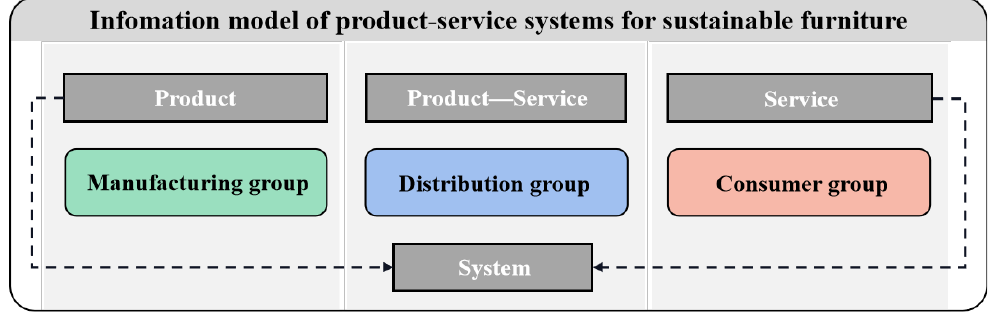
Figure 6. The composition of the product–service systems (PSSs) information model (IM) in this study (generated by authors).